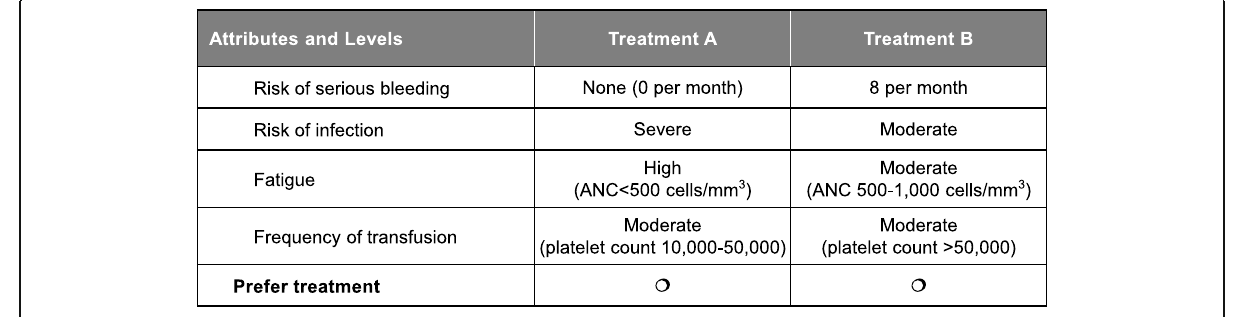
Fig. 1 Example of comparison card. Abbreviaton: ANC, Absolute Neutrophil